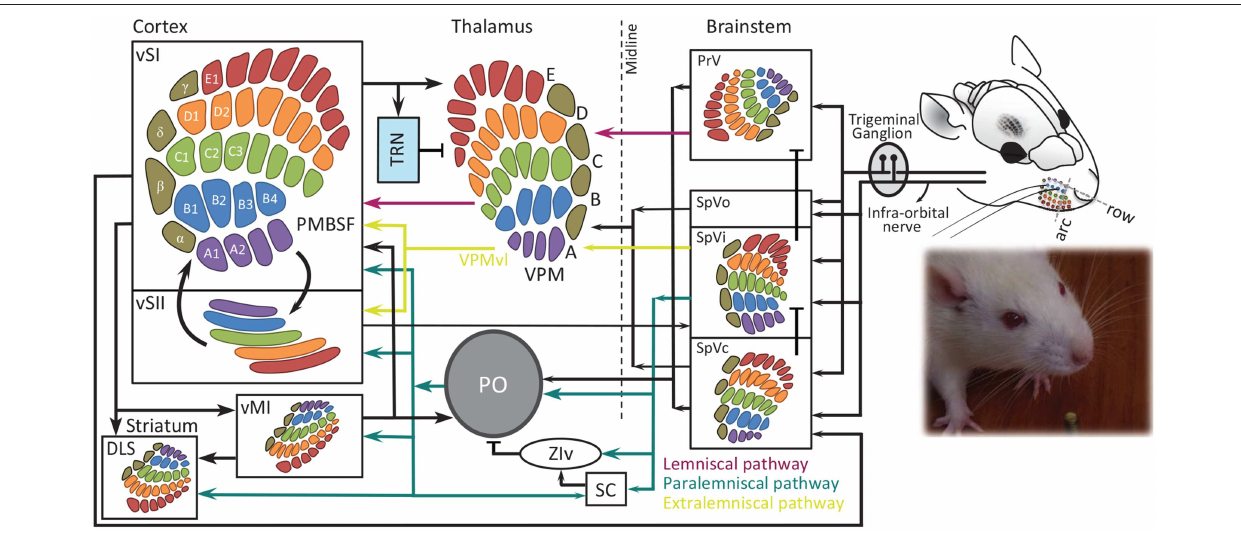
FIGURE 1 | Schematic representation of whisker-barrel system. Each whisker is identified by a unique letter-number combination corresponding to its row (A to E from dorsal to ventral) and arc (identified by numbers 1, 2 and etcetera from caudal to rostral), with α , β , γ , and δ straddlers between rows. Colors indicate rows. Barrel, barreloid and barrelets are redrawn from Durham and Woolsey (1984). PMBSF, posterior-medial barrel sub-field; PO, posterior thalamic nucleus; PrV, principal trigeminal nucleus; SC, superior colliculus; SpVi, spinal trigeminal nuclei pars interpolaris; SpVo, pars oralis; SpVc, pars caudalis; TRN, thalamic reticular nucleus; VPM, ventro-posterior medial nucleus; vMI, vibrissal primary motor cortex; vSI, vibrissal primary somatosensory cortex; vSII, secondary somatosensory cortex with the somatotopic map from Benison et al. (2007); DLS, dorsolateral striatum; ZIv, ventral zona inserta. The evidence for somatotopic map in vM1 is provided in Ferezou et al. (2007) and Sreenivasan et al.